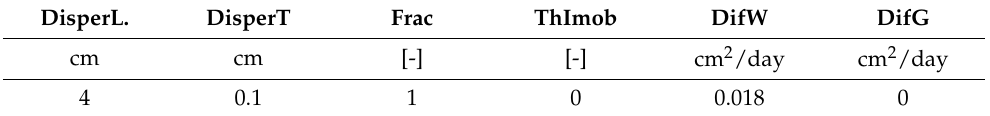
Table 2. Solute transport parameters.